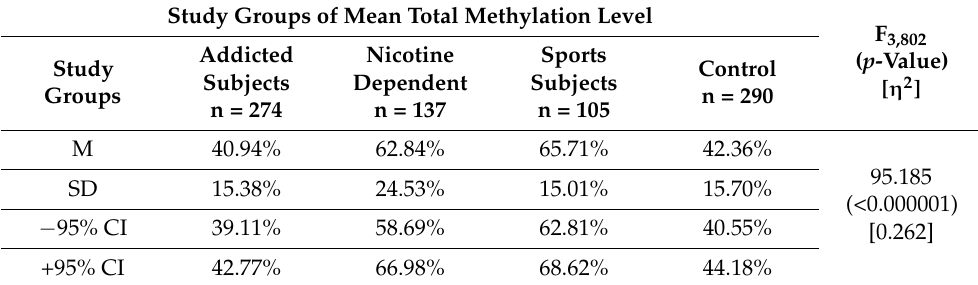
Table 2. The mean total methylation sites in a group of addicted subjects, nicotine-dependent subjects, sports subjects and